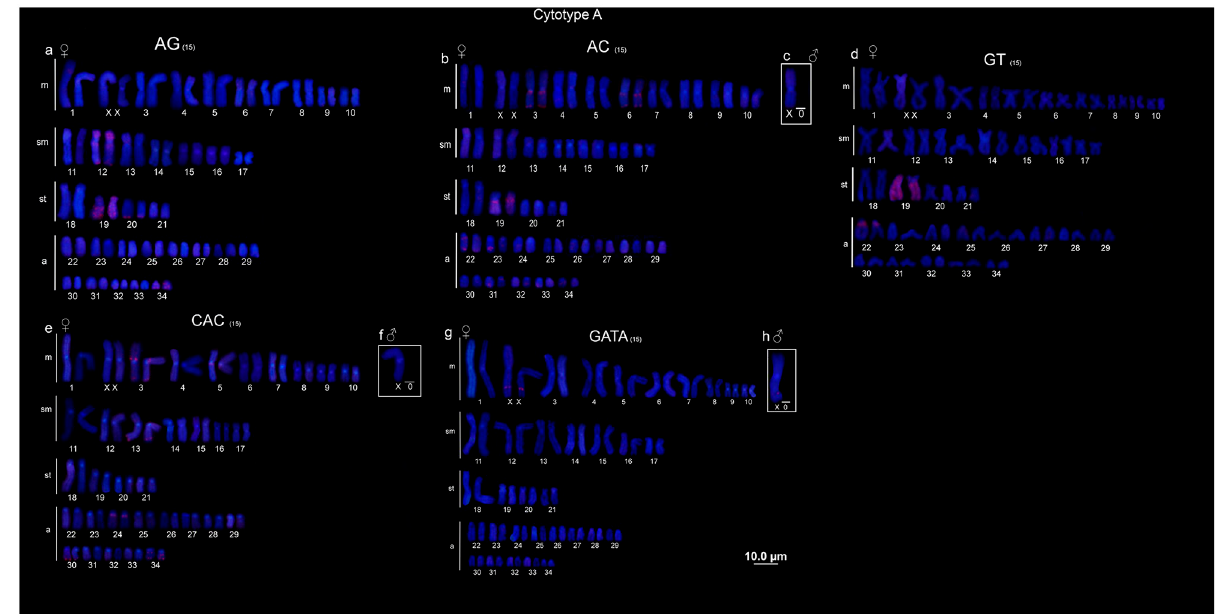
Fig 3. Microsatellites cytotype A. Microsatellite mapping (a) (AG) 15 , (b) (AC) 15 , (c) (GT) 15 , (d) (CAC) 15 and (e) (GATA) 4 in metaphases of cytotype A.